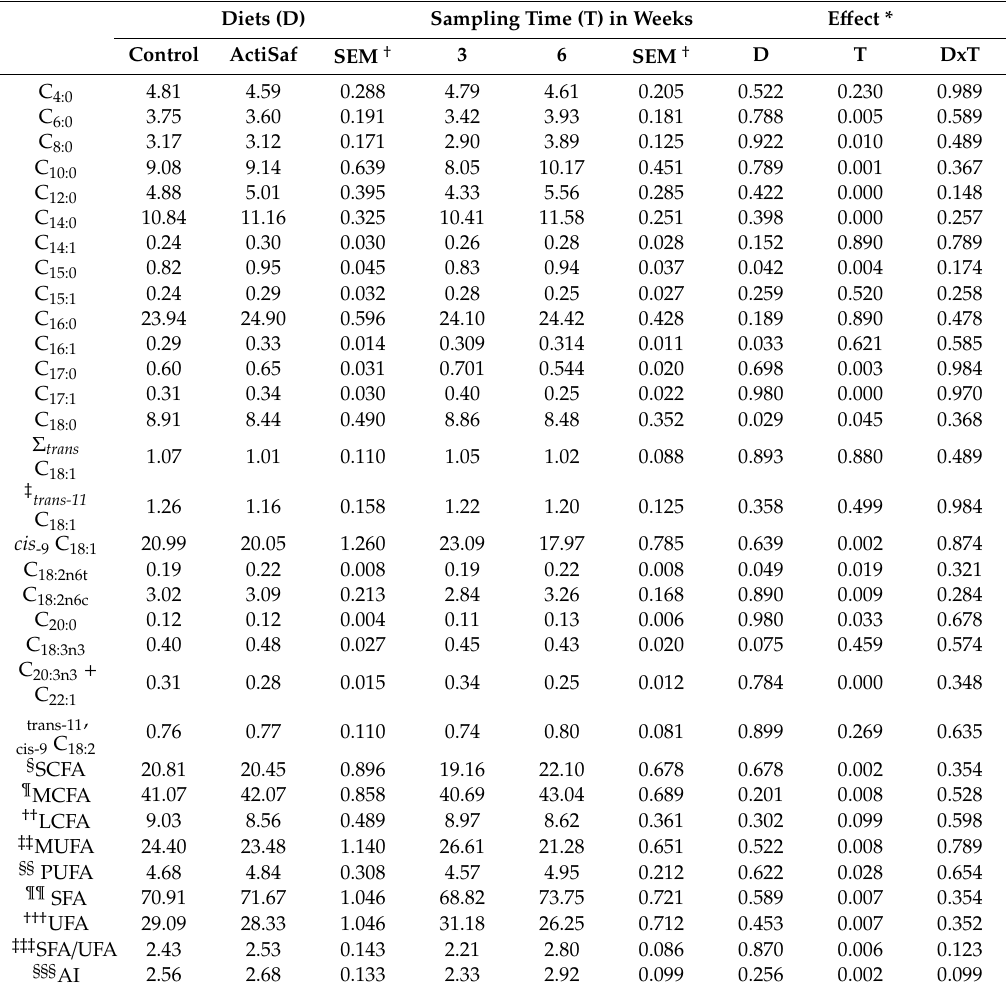
* E ff ect: The dietary treatment (D), time (T), and the interaction between dietary treatment × time (DxT) e ff ects were analyzed by analysis of variance (ANOVA) using a general linear model (GLM) for repeated measures and posthoc analysis was performed when appropriate using Tukey’s multiple range test. † SEM = Standard error of the mean. ‡ trans-11 C 18:1 = these values are not included in the Σ trans C 18:1 content. § SCFAs: Short-Chain Saturated Fatty Acids = C 6:0 + C 8:0 + C 10:0 + C 11:0 ; ¶ MCFAs: Medium-Chain Saturated Fatty Acids =